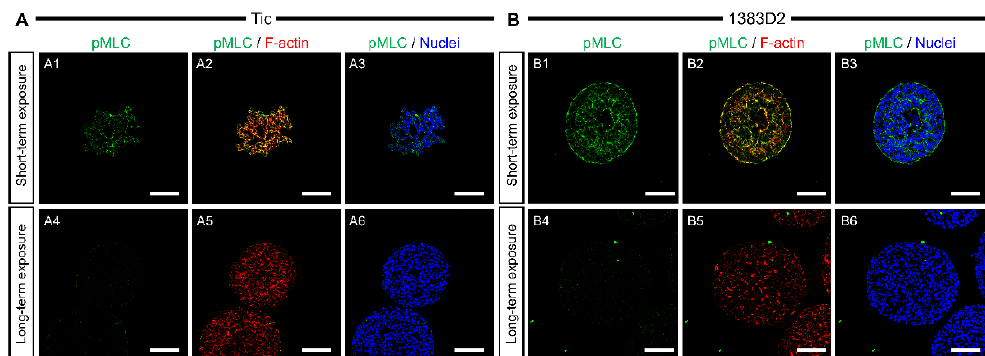
Figure 4. The effect of ROCK inhibitor on phosphorylated myosin (pMLC) and F-actin localization in the aggregates of two different hiPSC lines (( A ), Tic; ( B ), 1383D2) under short- and long-term exposure conditions. Florescent images of pMLC and F-actin at 120 h showing nuclei (blue), pMLC (green), and F-actin (red) ( A1 – B6 ). Scale bars, 100 μ m.